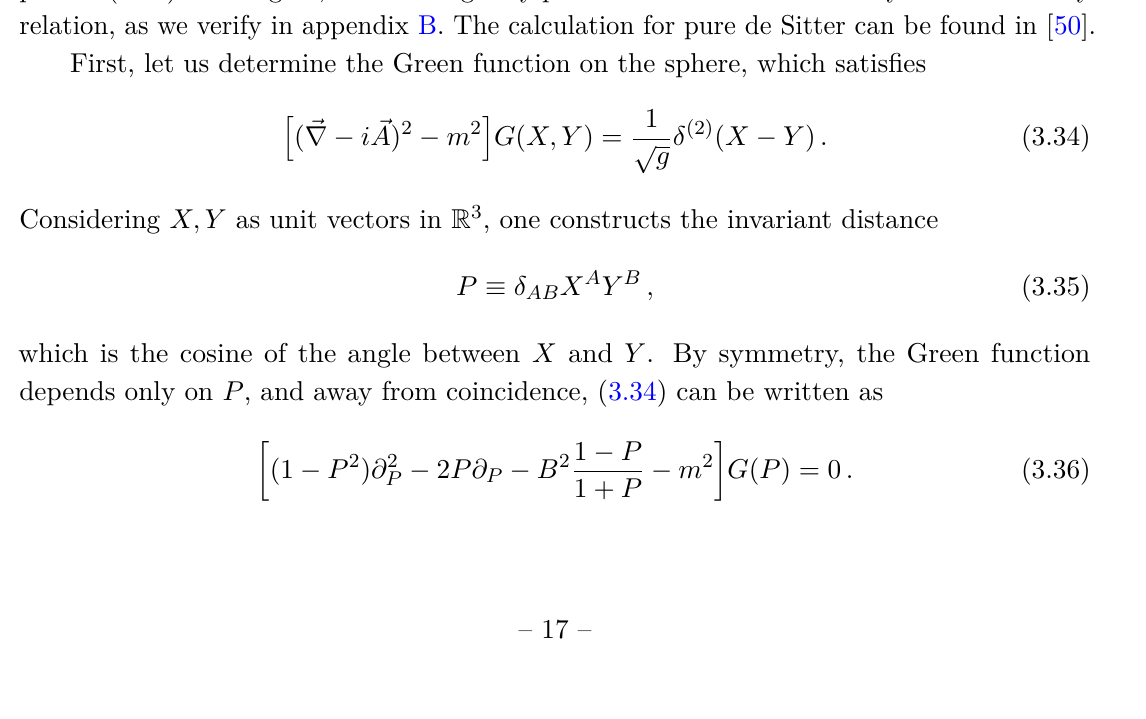
Coordinate space Green